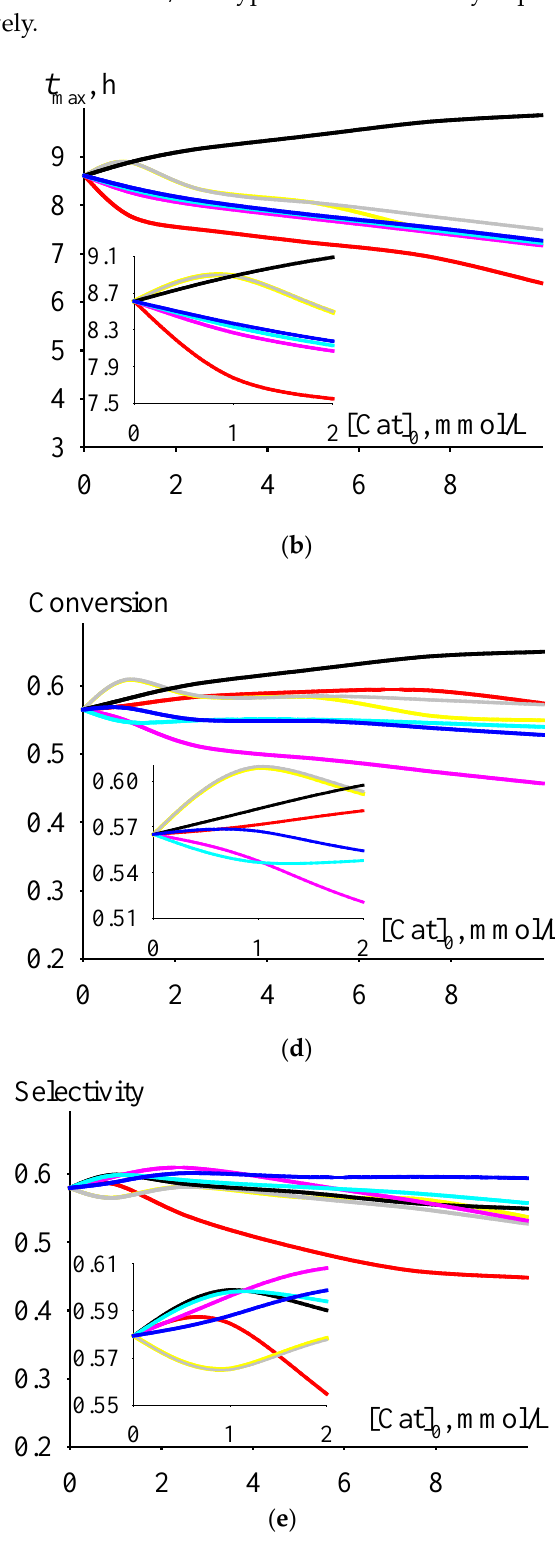
Figure 5. The dependencies of criterion C ( a ), t max ( b ), [ROOH] max ( c ), cumene conversion at t max ( d ), and selectivity at t max ( e ) versus initial catalyst concentration.